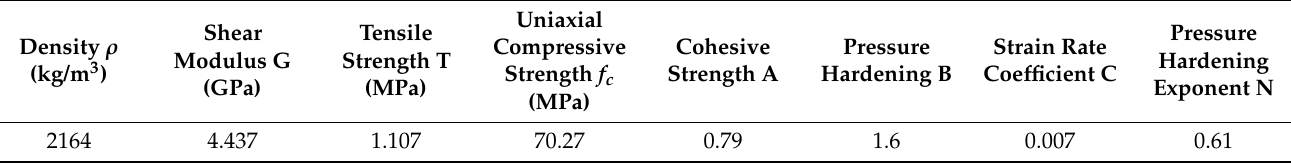
Table 3. HJC constitutive parameters of lunar rocks (Data from reference